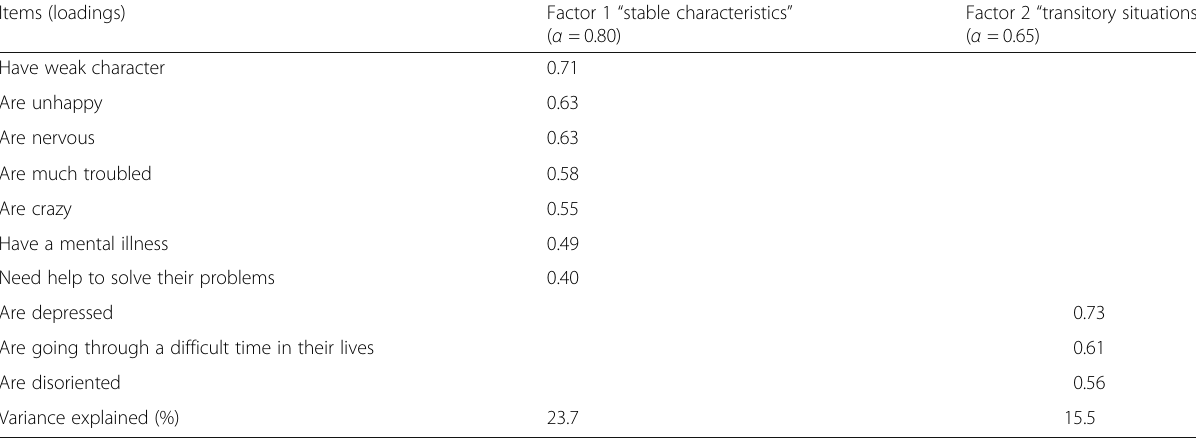
Table 1 Factorial structure, factorial loadings, explained variance and reliability of the SBPP scale — second version Items (loadings)